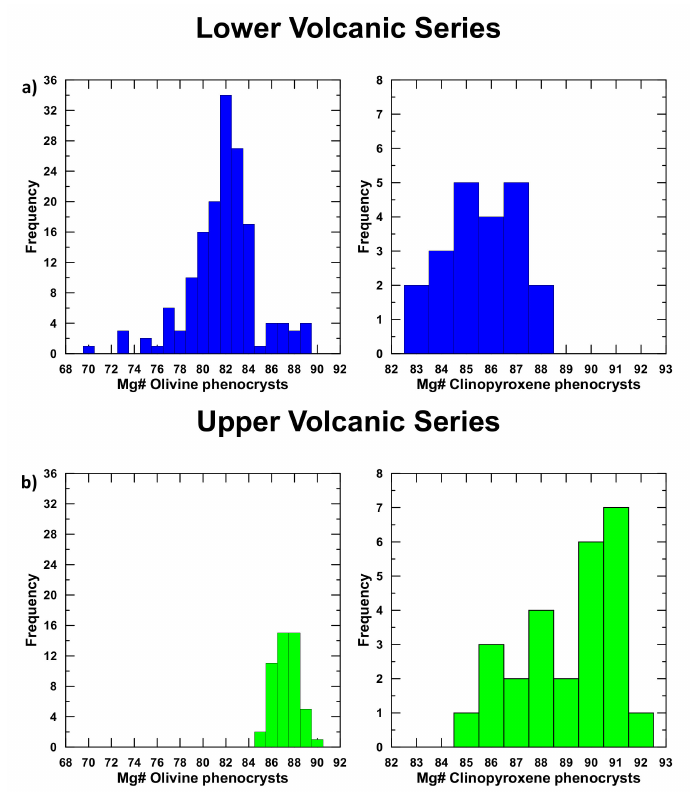
Figure 2. Histograms of olivine and clinopyroxene phenocryst compositions (Mg#) for primitive lava of Christmas Island; ( a ) Lower Volcanic Series (LVS) and ( b ) Upper Volcanic Series (UVS). Mineral data from Table